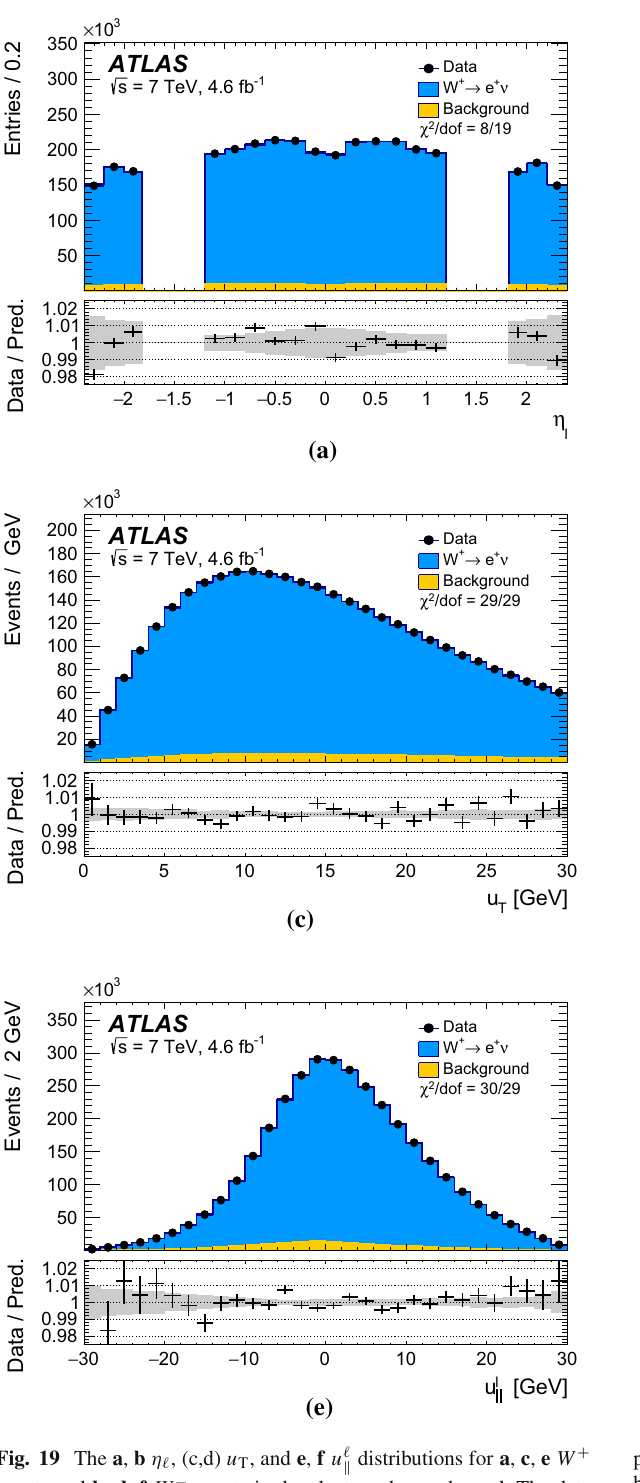
prediction ratios, the error bars show the statistical uncertainty, and the band shows the systematic uncertainty of the prediction. The χ 2 val- ues displayed in each figure account for all sources of uncertainty and include the effects of bin-to-bin correlations induced by the